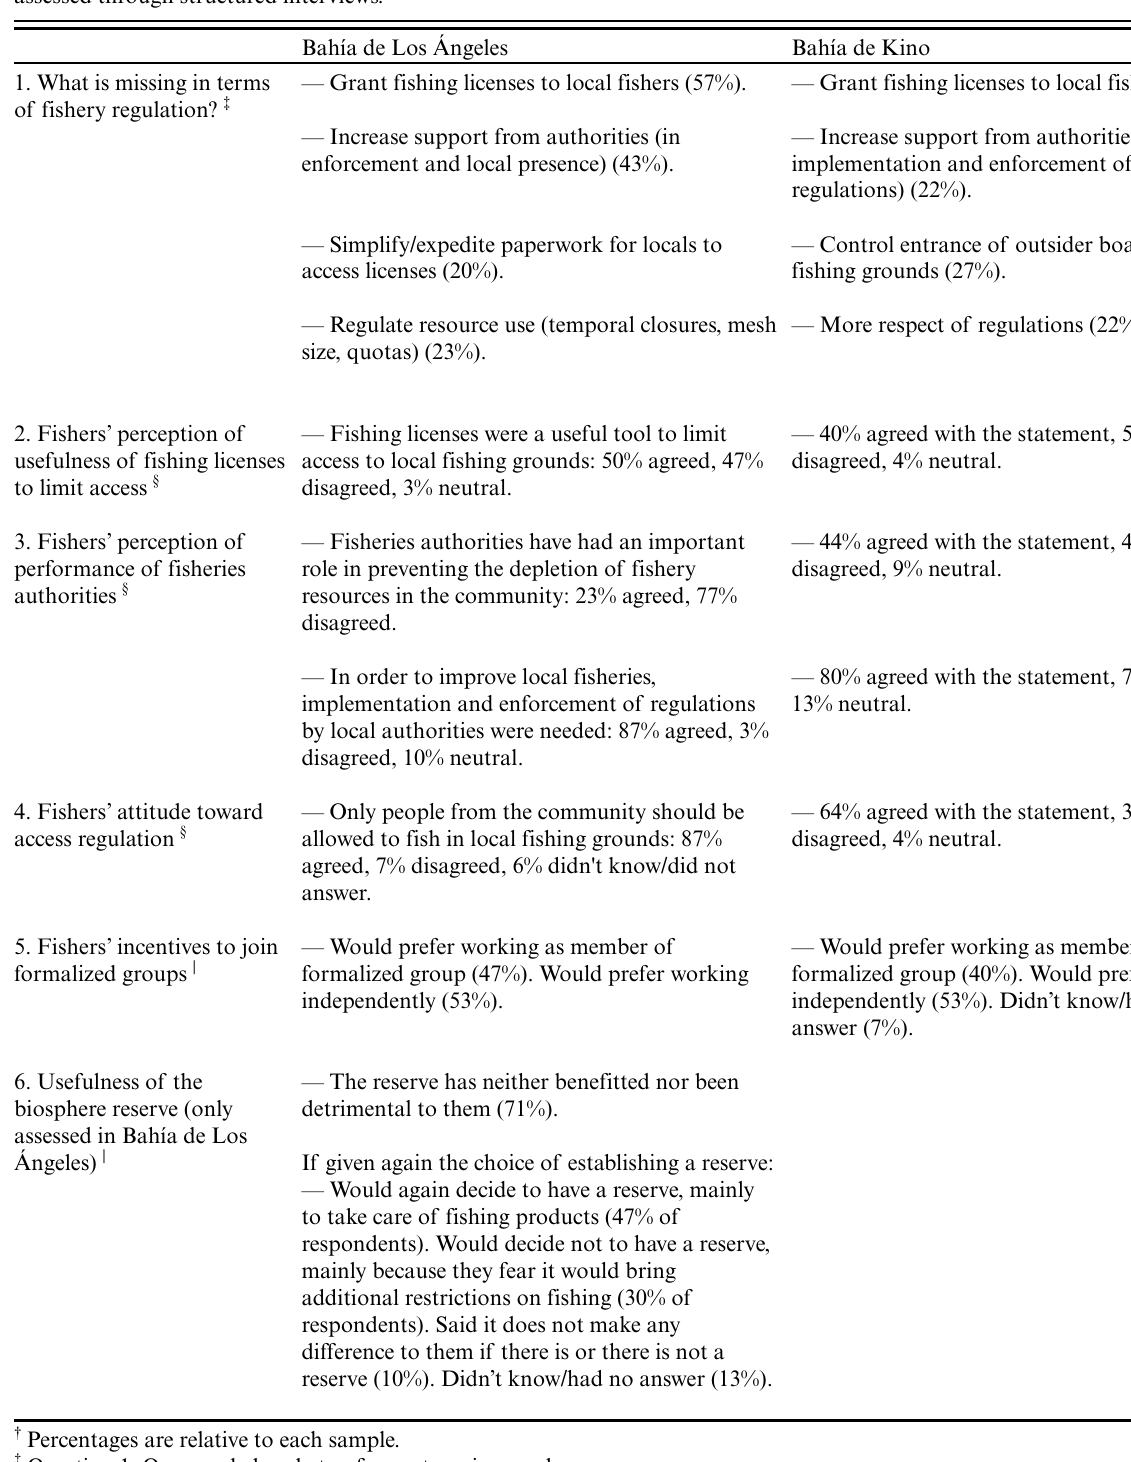
Table 2 . Fishers’ perceptions and attitudes about fisheries regulation in Bahía de Los Ángeles' and Bahía de Kino's small-scale fisheries, assessed through structured interviews.